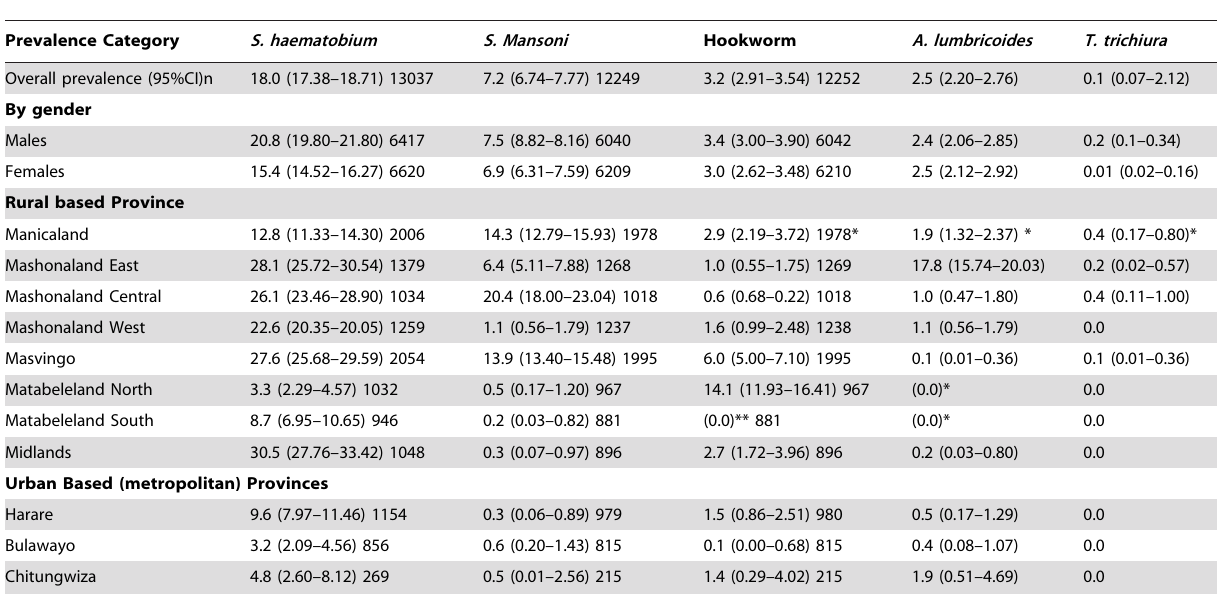
Table 2. Prevalence of schistosome and STH species by province in Zimbabwe in